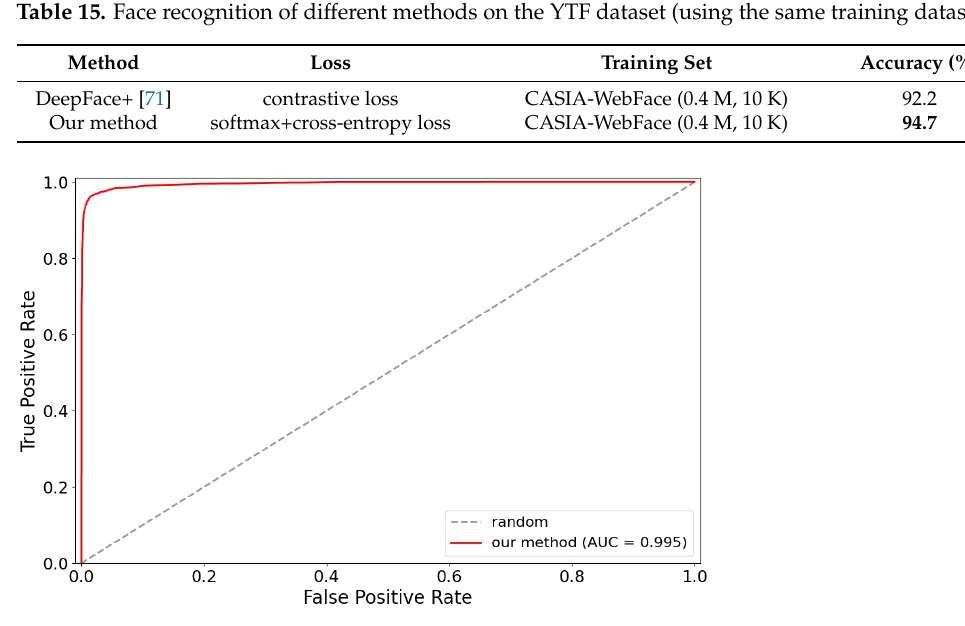
Figure 11. ROC curve for verification tasks on